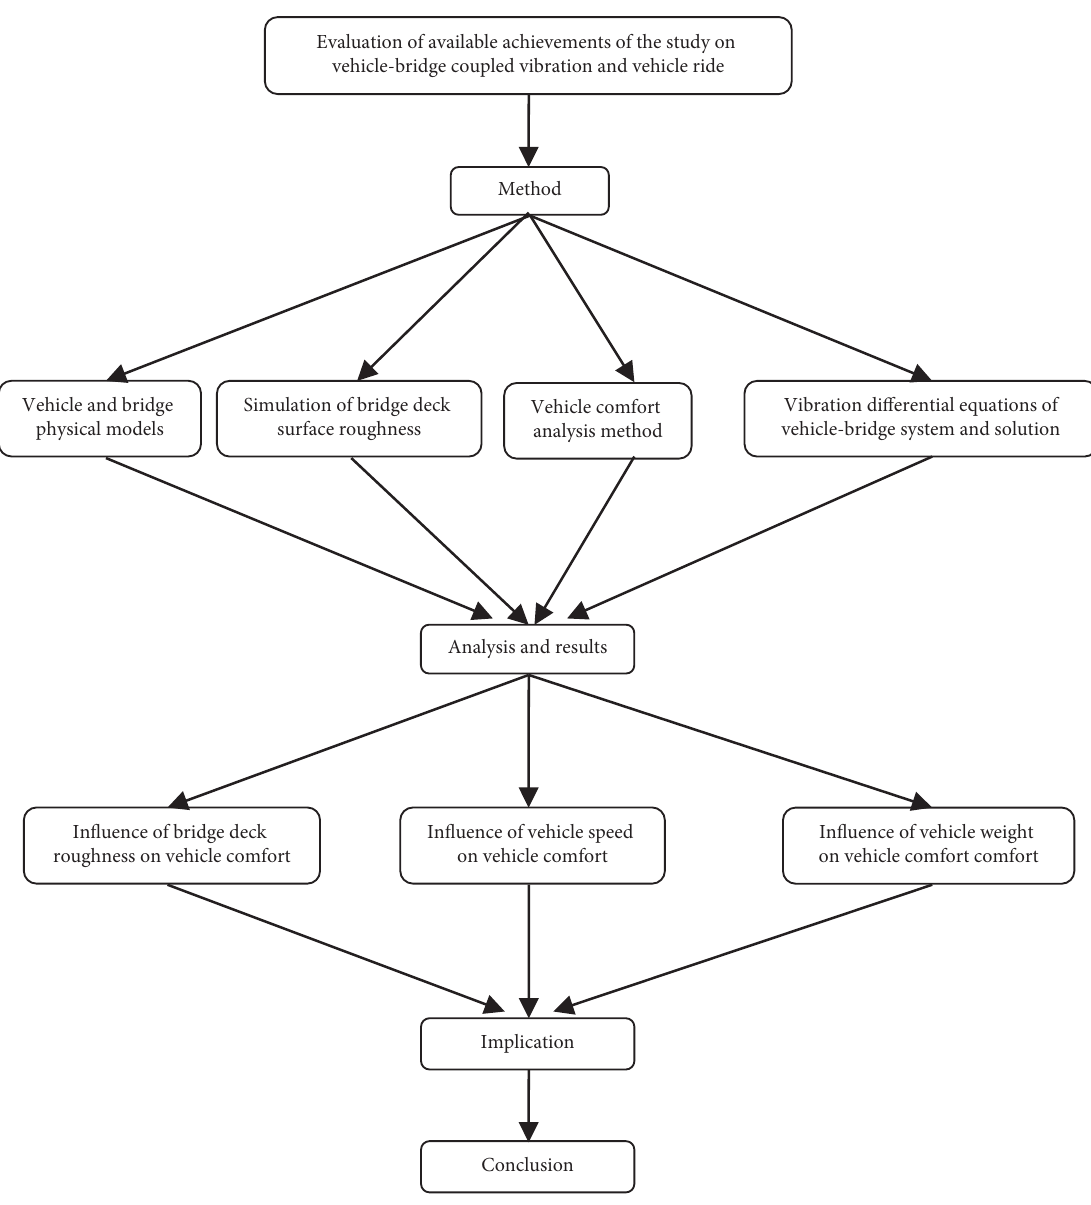
Figure 1: Article